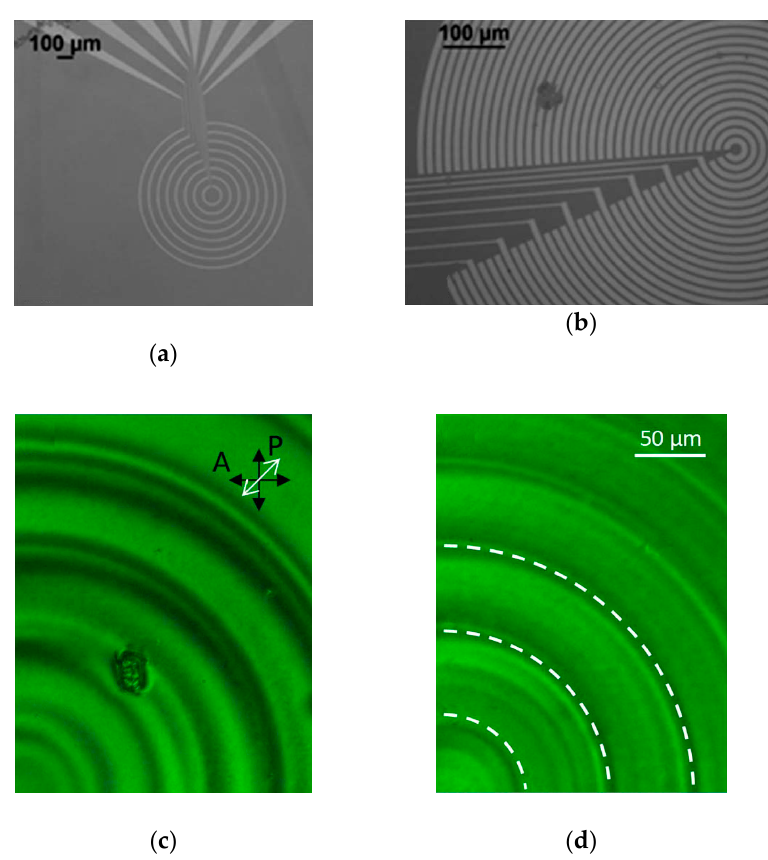
Figure 8. Reflection microscope image of the ITO electrode pattern for a lens ( a ) without floating electrodes and ( b ) with floating electrodes. Polarization microscope image of the LC devices with PZT ( c ) without floating electrodes and ( d ) with floating electrodes when 5 V is applied to all the electrodes. The rubbing direction is denoted with a white arrow. The position of the contacted electrodes is indicated with a white dashed line. Reprinted with permission from [145]. Copyright 2018 Optical Society of America.